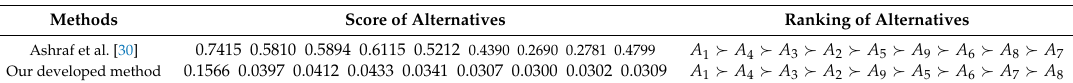
Table 2. Comparative